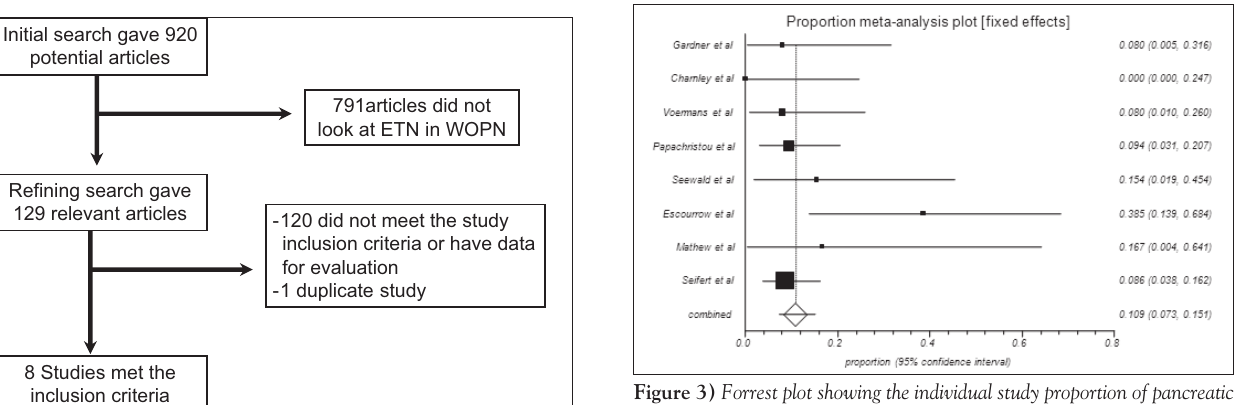
necosectomy recurrence after endoscopic transluminal necrosectomy